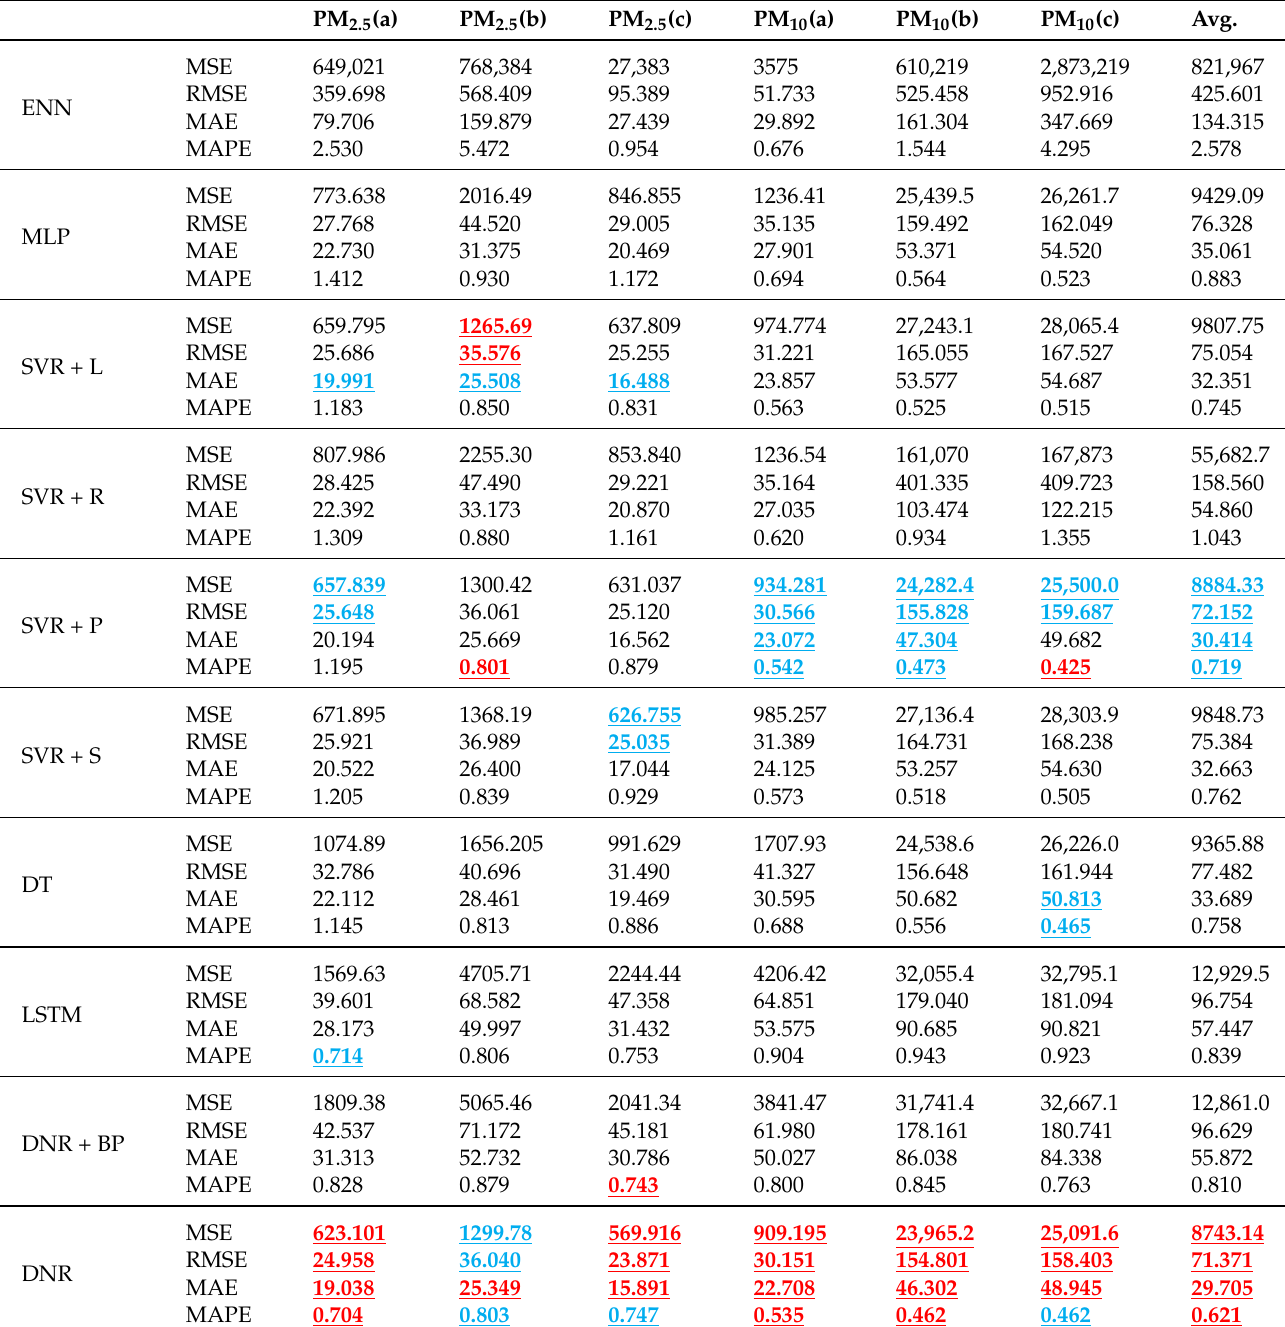
Table 5. Experimental results based on 30 runs of all the models on the six air quality datasets. The best and second-best results are highlighted in red and blue,